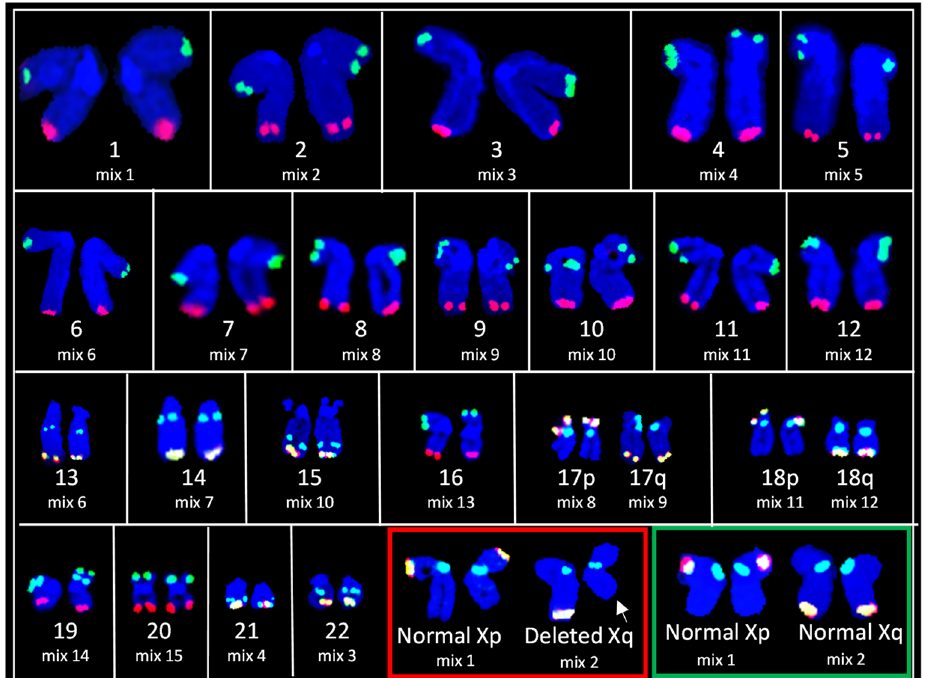
Figure 2. Composite karyogram from 15 metaphase spreads hybridized with the ToTelVysion (TV) subtelomeric probe set. Each chromosome pair is labeled with its respective TV probe mix (see Table 1). Red and green boxes show consecutive hybridizations for deletion of chromosome Xq terminal and normal Xq terminal regions, respectively. White arrow indicates deletion of Xq terminal region (see supplemental Figure S2 for metaphase images).